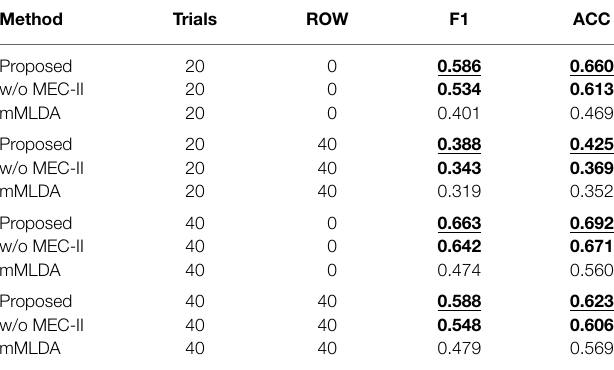
TABLE 3 | Experimental results of action description task for 20 and 40 trials.